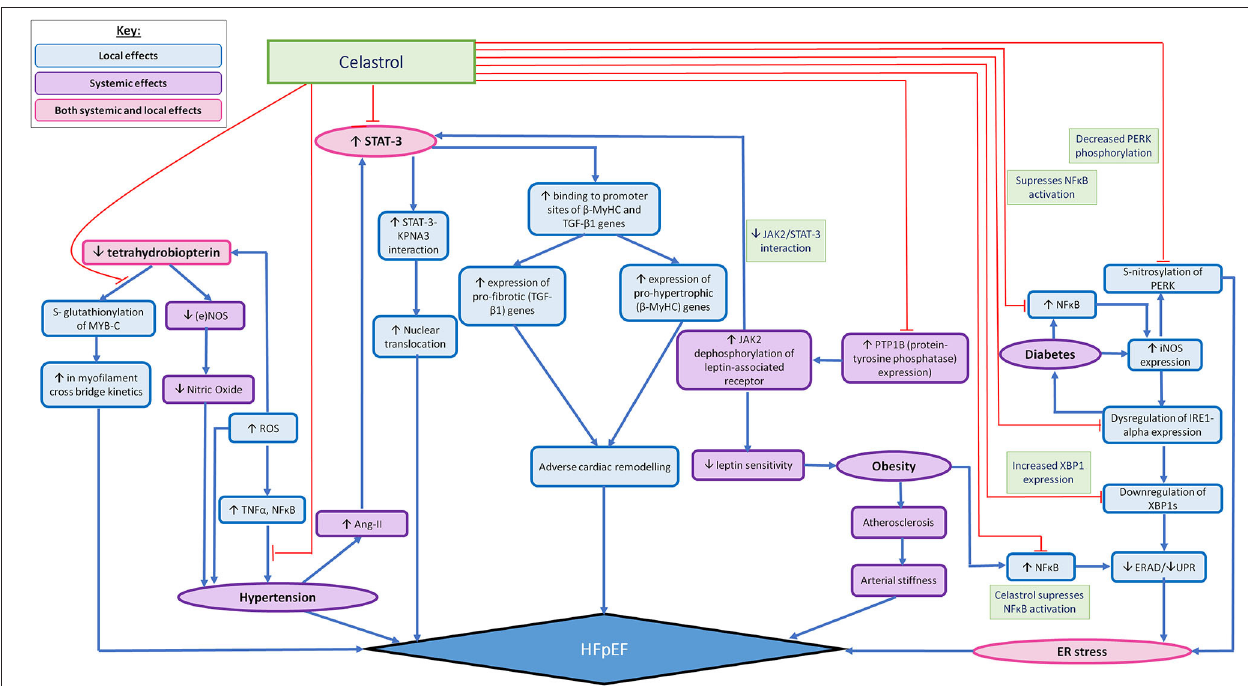
FIGURE 1 | Summarising the possible widespread effects of Celastrol in mediating localised (in relation to the heart) and systemic pathophysiological mechanisms that are thought to lead to HFpEF. The pathophysiological processes that lead to the development of HFpEF are demonstrated by the pathways illustrated with blue arrows. The red arrows outline the pathways which can be altered by the action of Celastrol, so as to impede the pathophysiological development of HFpEF. The local effects of Celastrol are demonstrated by the blue (accent 5) boxes, the systemic effects are demonstrated by the purple boxes and the combined local and systemic effects are demonstrated by the pink